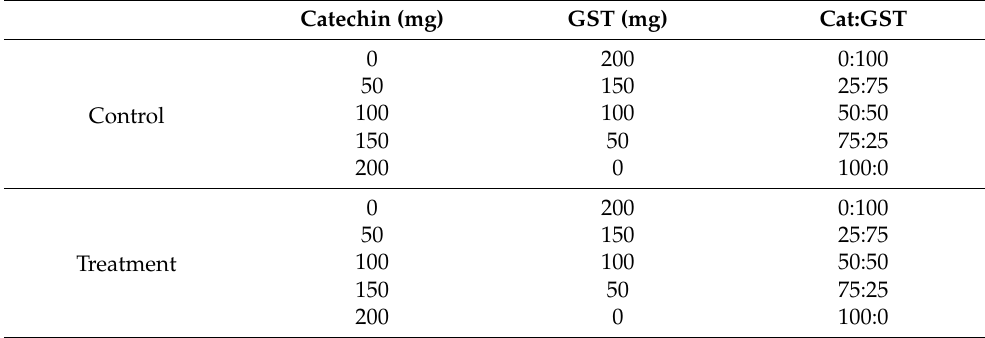
Table 1. A summary of various catechin (Cat) and grape seed tannin mixtures used to examine the effects of oxidation using horseradish peroxidase and hydrogen peroxide model system. The compounds mixtures were dissolved in ethanol: water: TRIS buffer (pH 7.4) at 2.4: 20 and 19.2 v / v